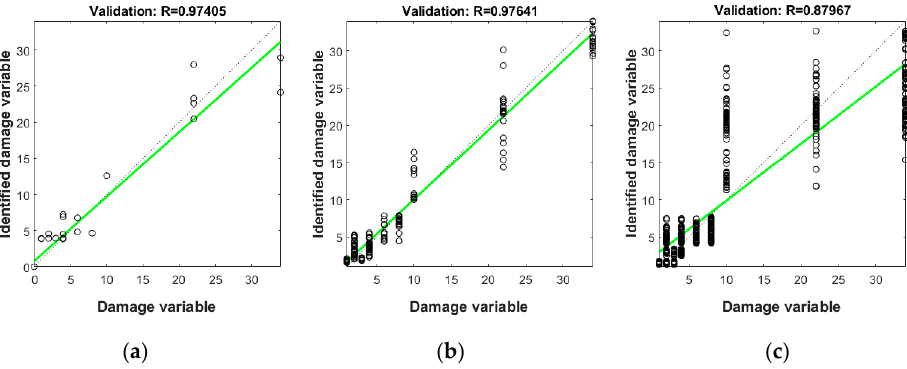
Figure 9. Damage identification accuracy according to: ( a ) Type 1; ( b ) Type 2; ( c ) Type 3.